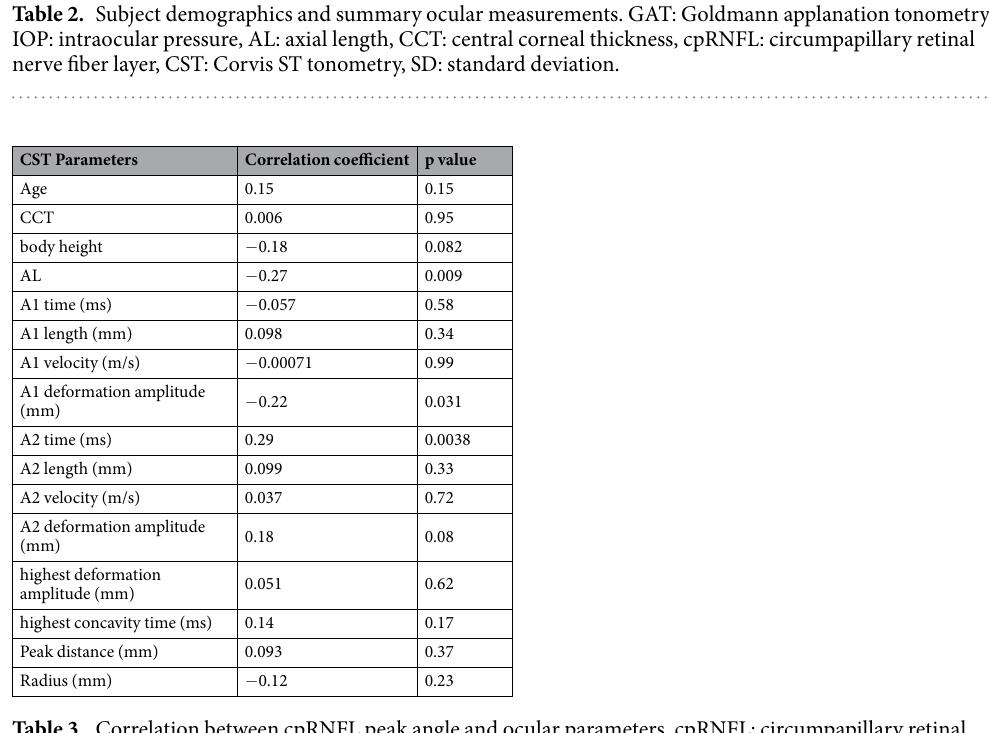
Table 3. Correlation between cpRNFL peak angle and ocular parameters. cpRNFL: circumpapillary retinal nerve fiber layer, CST: Corvis ST tonometry, CCT: central corneal thickness, AL: axial